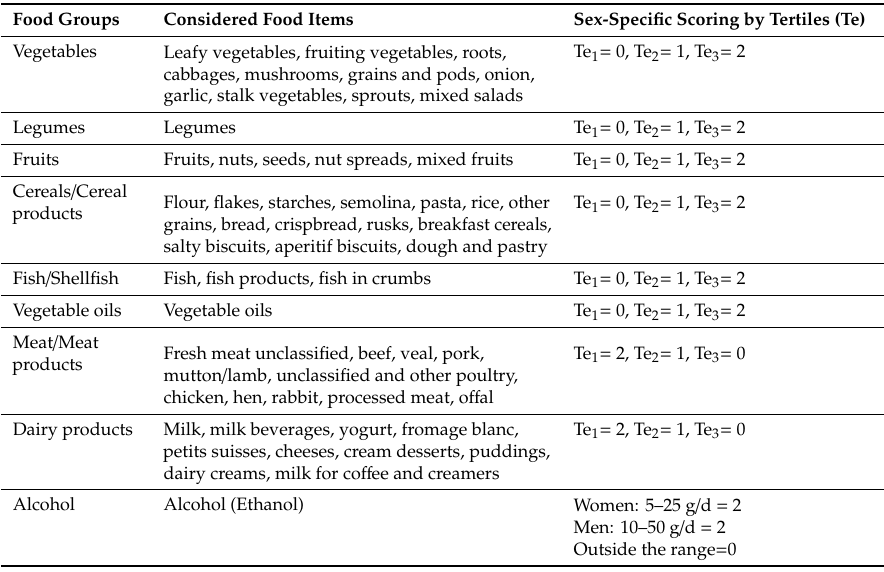
Table A1. Calculation of the MED diet